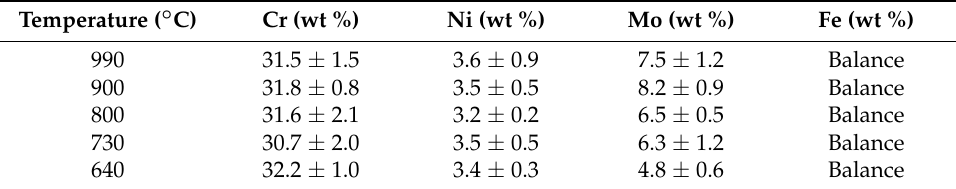
Table 3. Chemical composition of σ formed at different aging